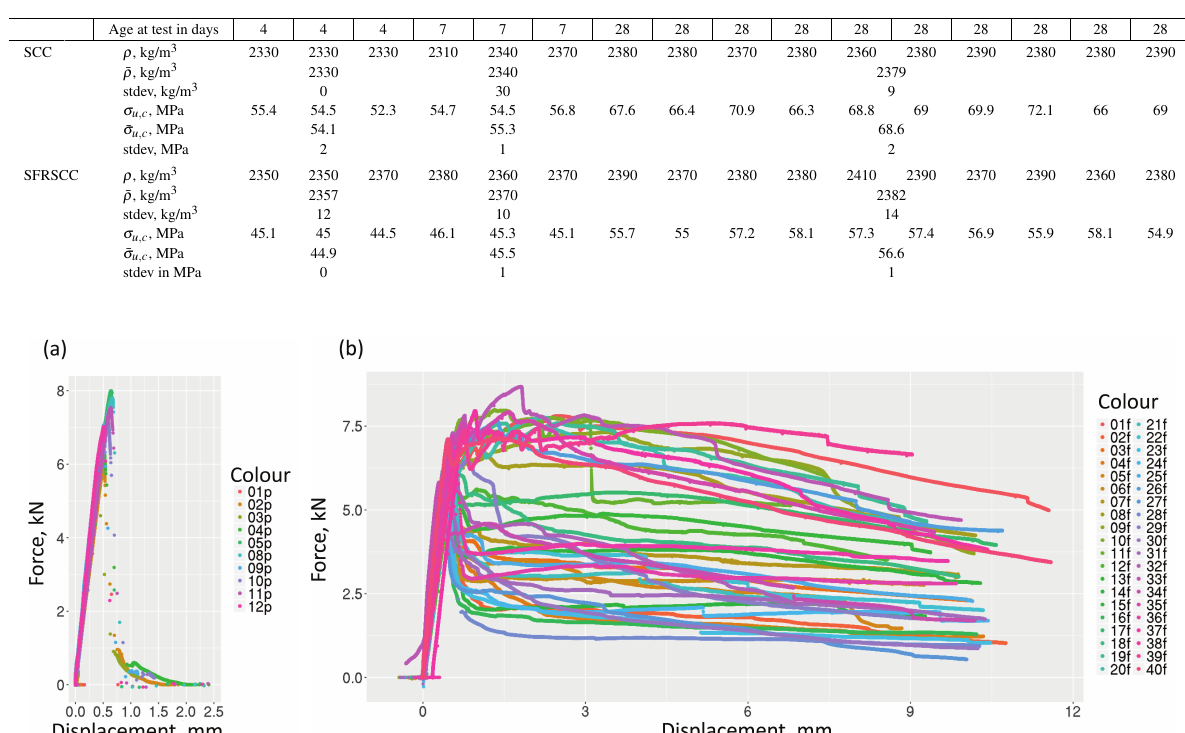
Table 3. Results of compression tests for SCC and SFRSCC